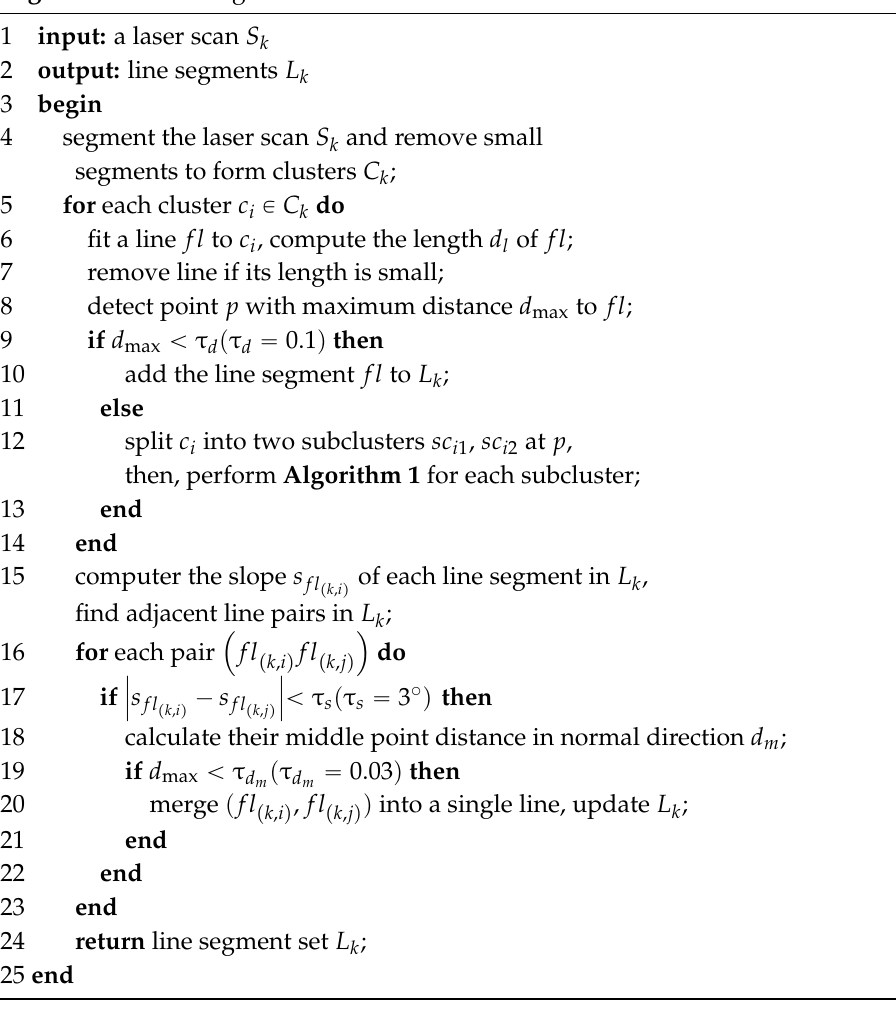
Algorithm 1. Line Segment